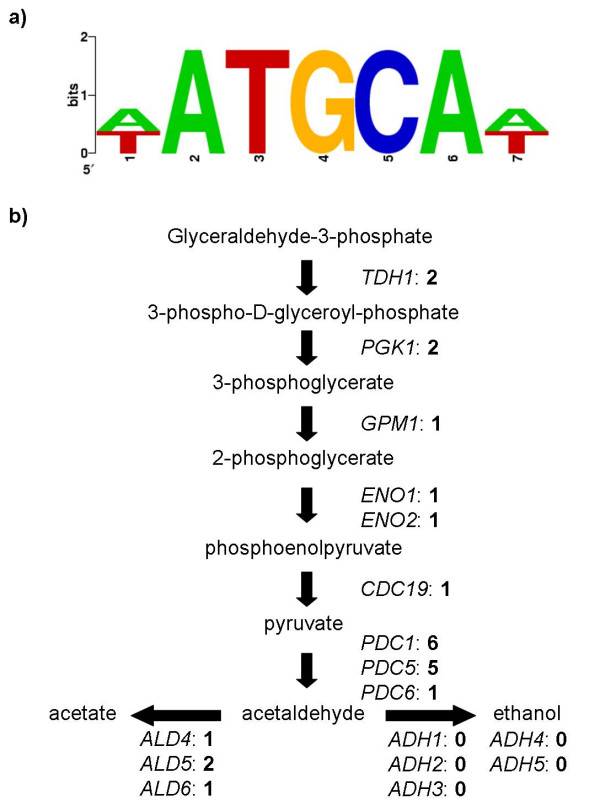
(a) Sequence logo [41] of putative regulatory motif. (b) Subsection of the glucose fermentation pathway. Numbers represent the occurrences of the putative motif in the gene's promoter.